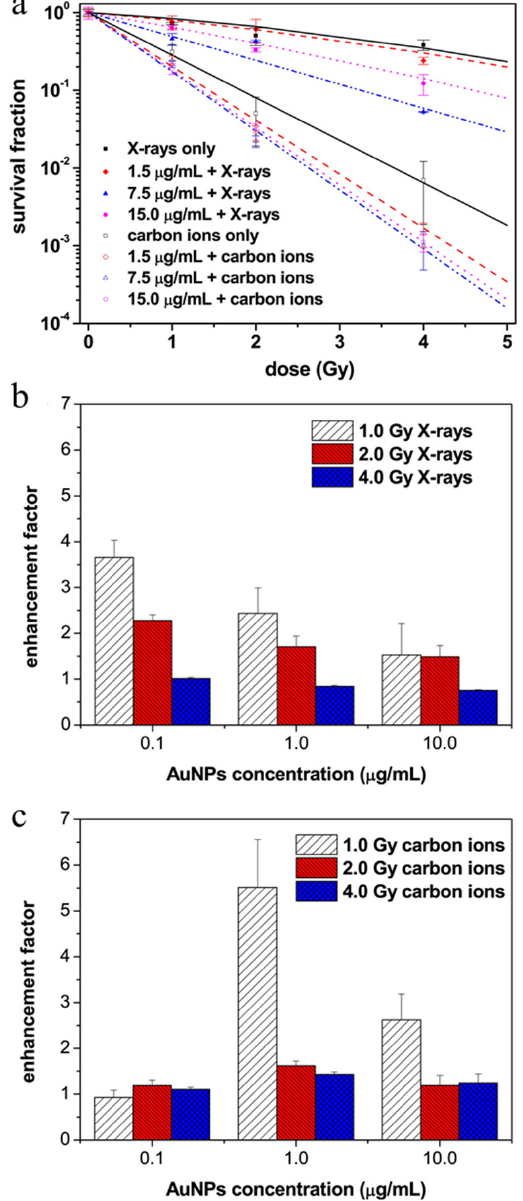
Figure 3. ( a – c ) Radiation enhancement effect of 14 nm citrate-capped gold nanoparticles (AuNPs). ( a ) AuNPs improve the cell-killing effects of X-rays and fast carbon ions. ( b ) AuNPs improve the hydroxyl radical production of X-rays (assessed by 3-CCA). ( c ) AuNPs improve the hydroxyl radical production of carbon ions (assessed by 3-CCA). Reproduced with permission from Ref. [92]. Copyright Elsevier 2015.